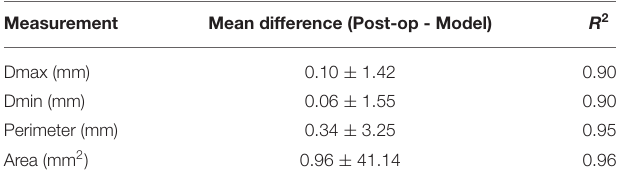
TABLE 2 | Mean ( ± SD) difference between the measurements of the observed (post-operative) and simulated (model) devices and respective R-squared coefficient for the different levels of the devices.